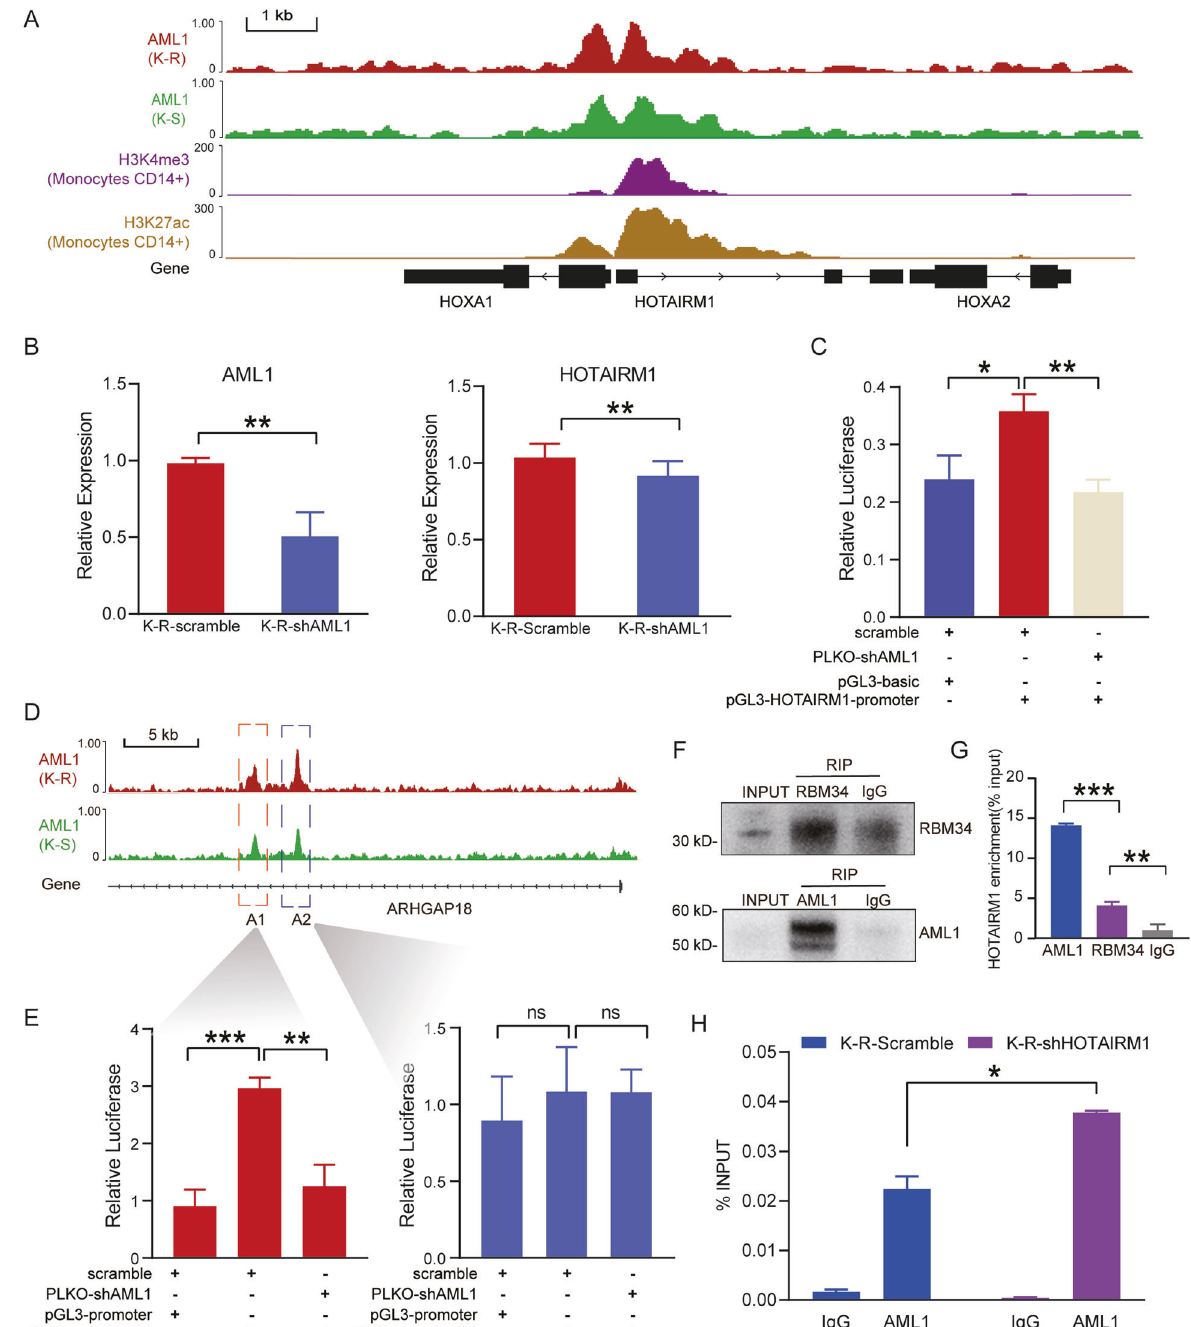
Fig. 6 ARHGAP18 increased GC sensitivity by RHOA/ROCK1 pathway. A Cell viability rate in control or ARHGAP18 knockdown K-S cells after Dex (10 µM) treatment from day 0 to day 4. B Flow cytometry analysis of Annexin V and PI in control or ARHGAP18 knockdown K-S cells. Both cells were treated with vehicle and 10 µM dexamethasone for 48 h prior to staining. C Relative expression of BCL2L11 in control or ARHGAP18 knockdown K-S cells. D Cell viability rate in control and ARHGAP18 overexpression K-R cells after Dex (10 µM) treatment from day 0 to day 3. E Relative expression of BCL2L11 in control or ARHGAP18 overexpression K-R cells. F Relative expression of ARHGAP18, BCL2, and BCL2L11 in control or HOTAIRM1 knockdown K-R cells. G Cell viability rate after Dex (10 µM) treatment from day 0 to day 4. HOTAIRM1 knockdown K-R cells decreased gradually to 50% from day 0 to day 4. ARHGAP18 knockdown rescued the decrease of GC resistance caused by the knockdown of HOTAIRM1. H Western blot showing RhoA-GTP and total RhoA in different cells. The protein bands were analyzed in grayscale using Image J software to determine the ratio of RhoA-GTP to total RhoA. The β -actin was internal control. I Analysis of MYPT phosphorylated levels in control and HOTAIRM1 knockdown K-R cells. The protein bands were analyzed with Image J software to calculate the relative grayscale value of proteins between samples. The β -actin was the internal control. J Cell viability rate of K-R cells treated with ROCK1 inhibitors RKI-1447 (1 µM), Dex (10 µM) and combined drugs for 1 – 5 days, respectively. Data information: Data were represented as mean ± SD, n = 3 ( A, C, D – F, I ). Difference between groups was assessed using Student ’ s t -test: * p < 0.05, ** p < 0.01, *** p < 0.001, ns means no statistical signi fi